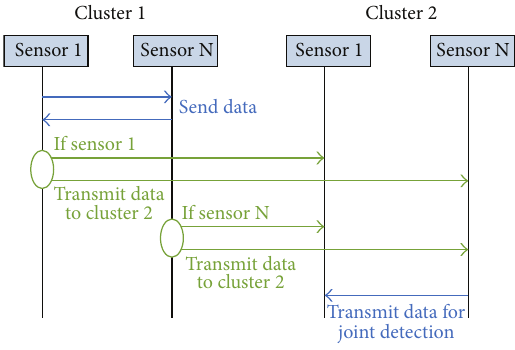
Figure 3: The communication process of